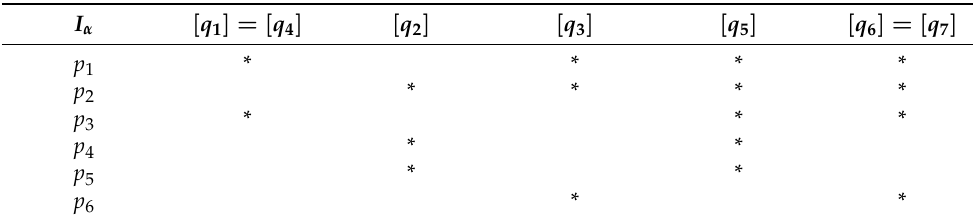
Table 2. A column clarified context.